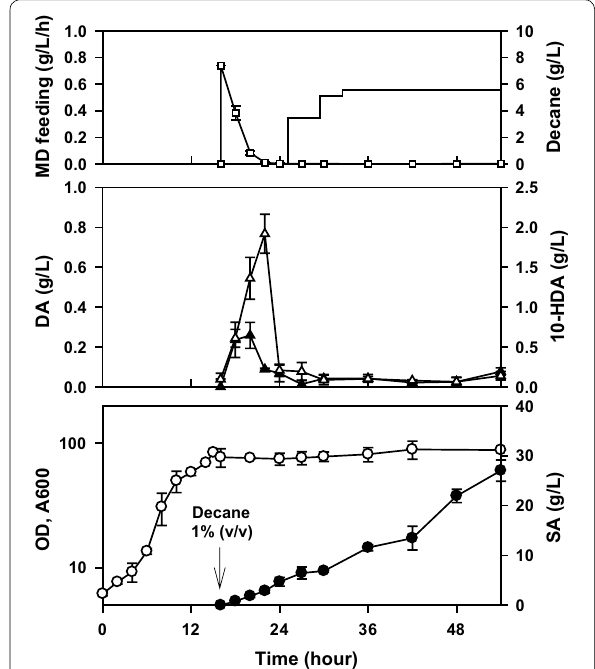
Fig. 1 Biotransformation of methyl decanoate to sebacic acid using an evolved Candida tropicalis strain with decane induction method. This experiment was adapted from that described in a previous report after several modifications (Beardslee et al. 2014). After the completion of the growth phase, decane induction was conducted for 10 h using 10% v/v decane. Thereafter, methyl decanoate was fed slowly (and subsequently increased in a sequential manner) after decane induction to avoid the accumulation of decanoic acid. Error bars represent standard deviation of three measurements from two independent runs. OD optical density, SA sebacic acid, DA